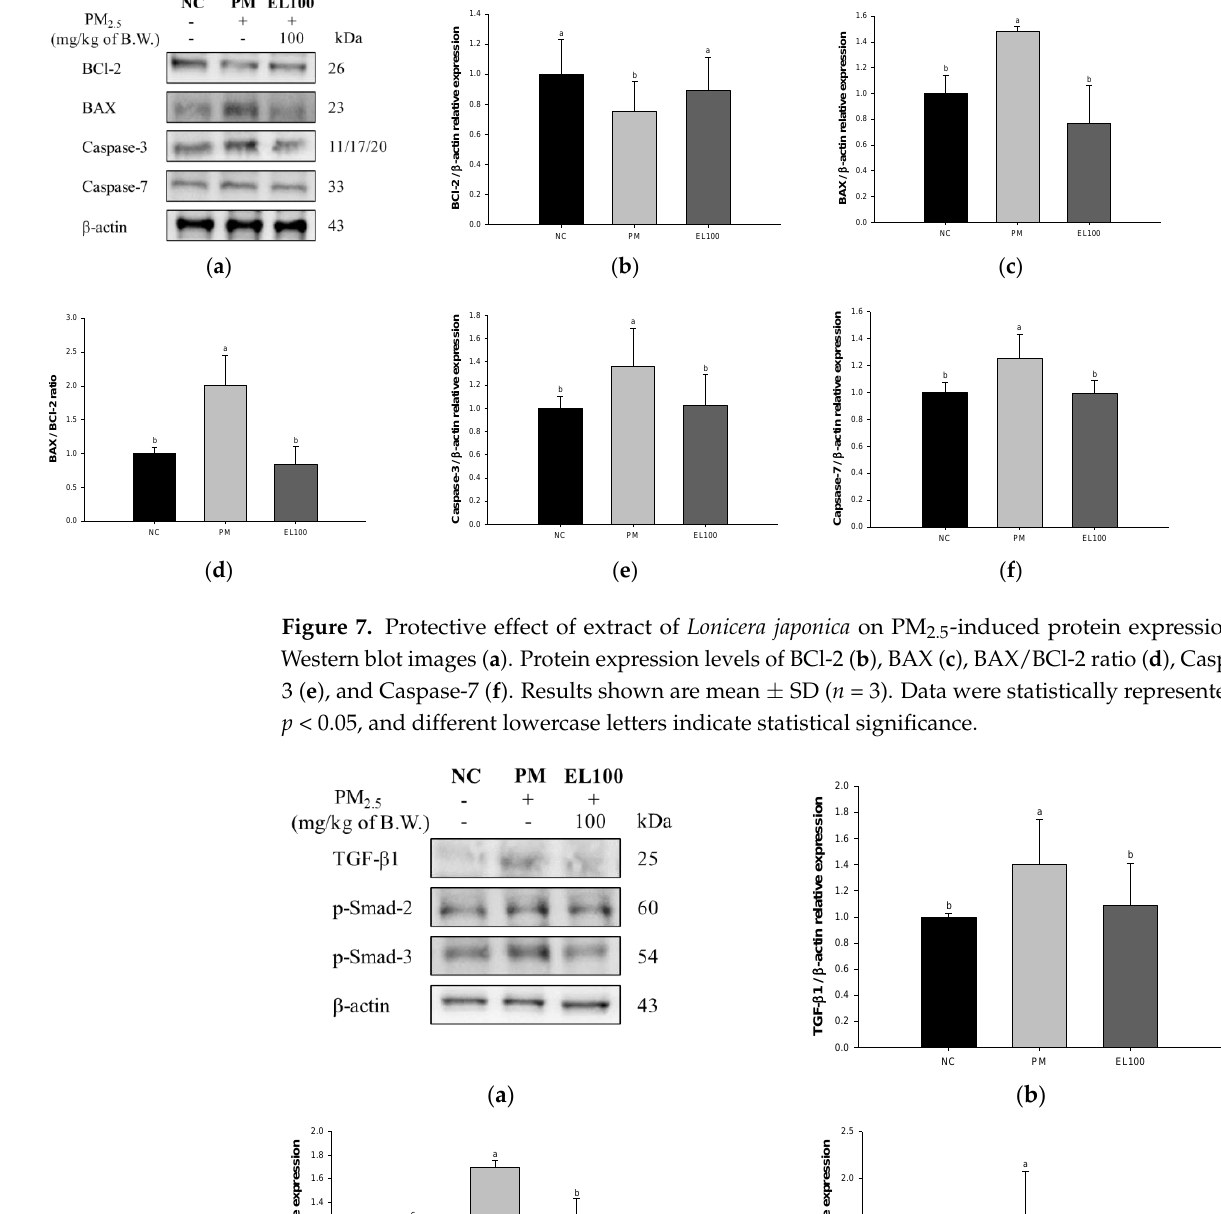
Figure 8. Protective effect of extract of Lonicera japonica on PM 2.5 -induced protein expression of Western blot images ( a ). Protein expression levels of TGF-β1 ( b ), p-Smad-2 ( c ), and p-Smad-3 ( d ). Results shown are mean ± SD ( n = 3). Data were statistically represented at p < 0.05, and different lowercase letters indicate statistical significance.